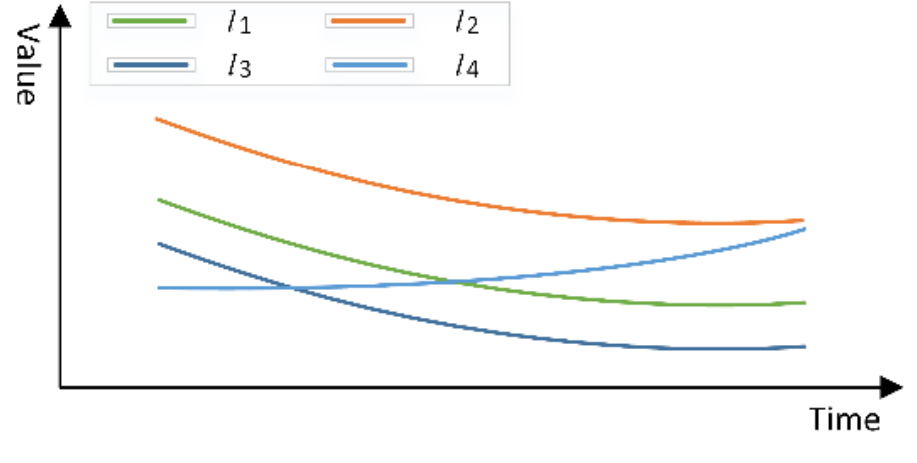
Figure 1. Time series objects with equal time interval.